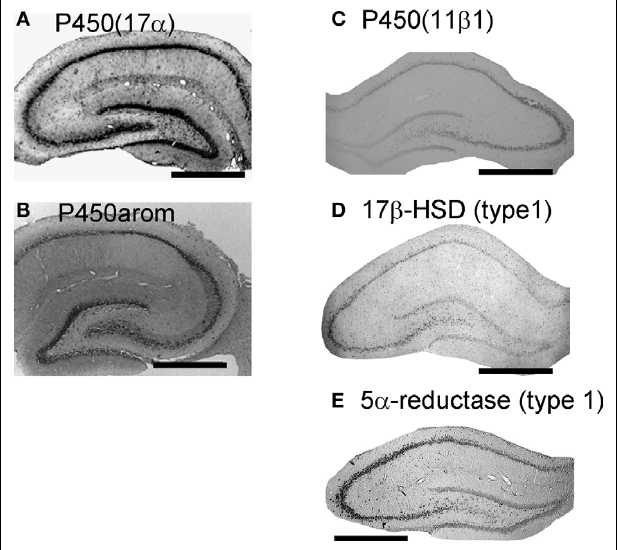
FIGURE 1 | Localization of the enzymes required for synthesis of sex steroids and corticosteroids in the hippocampus. (A) and (B) Immunohistochemical staining of P450(17 α ) (A) and P450arom (B) in the coronal section of the adult male rat hippocampus. (C–E) In situ hybridization analysis of P450 (11 β 1) (C) , 17 β -HSD (type 1) (D) and 5 α -reductase (type 1) (E) with antisense probes. All steroidogenic enzymes are mainly expressed in neurons, although a weak expression is observed in some glial cells. Scale bar, 800 μ m. Modified from Hojo et al. (2004, 2009), Higo et al.